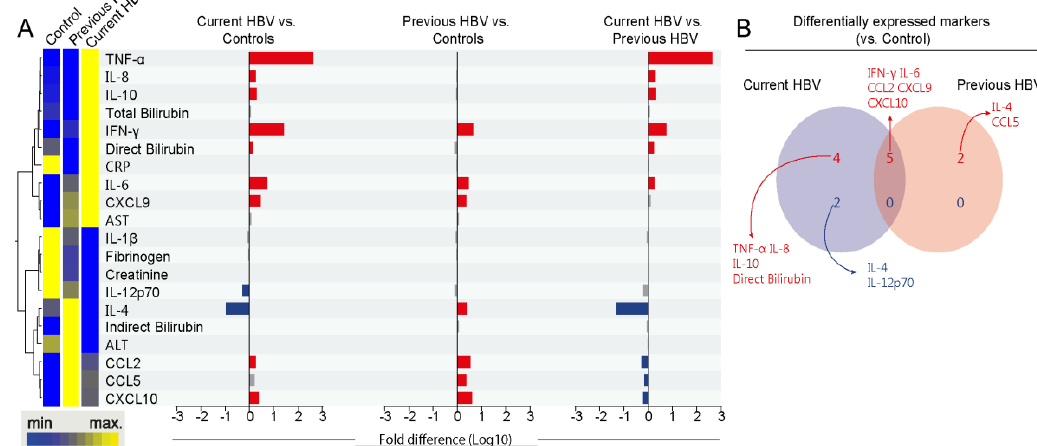
Figure 1. Systemic inflammatory profile of the study population. ( A ) Left panel: A hierarchical cluster analysis (Ward’s method) was employed to describe the overall expression pattern of plasma biomarkers in the study population. Dendrograms represent Euclidean distance. Right panel: Fold-di ff erences in plasma levels of the indicated biomarkers between the study groups. Di ff erences that reached statistical significance after adjustment for multiple comparisons (adjusted p < 0.05) are represented in colored bars. ( B ) Venn diagram demonstrates markers whose values were statistically di ff erent between each hepatitis B virus (HBV) group (current or previous infected) and healthy controls.